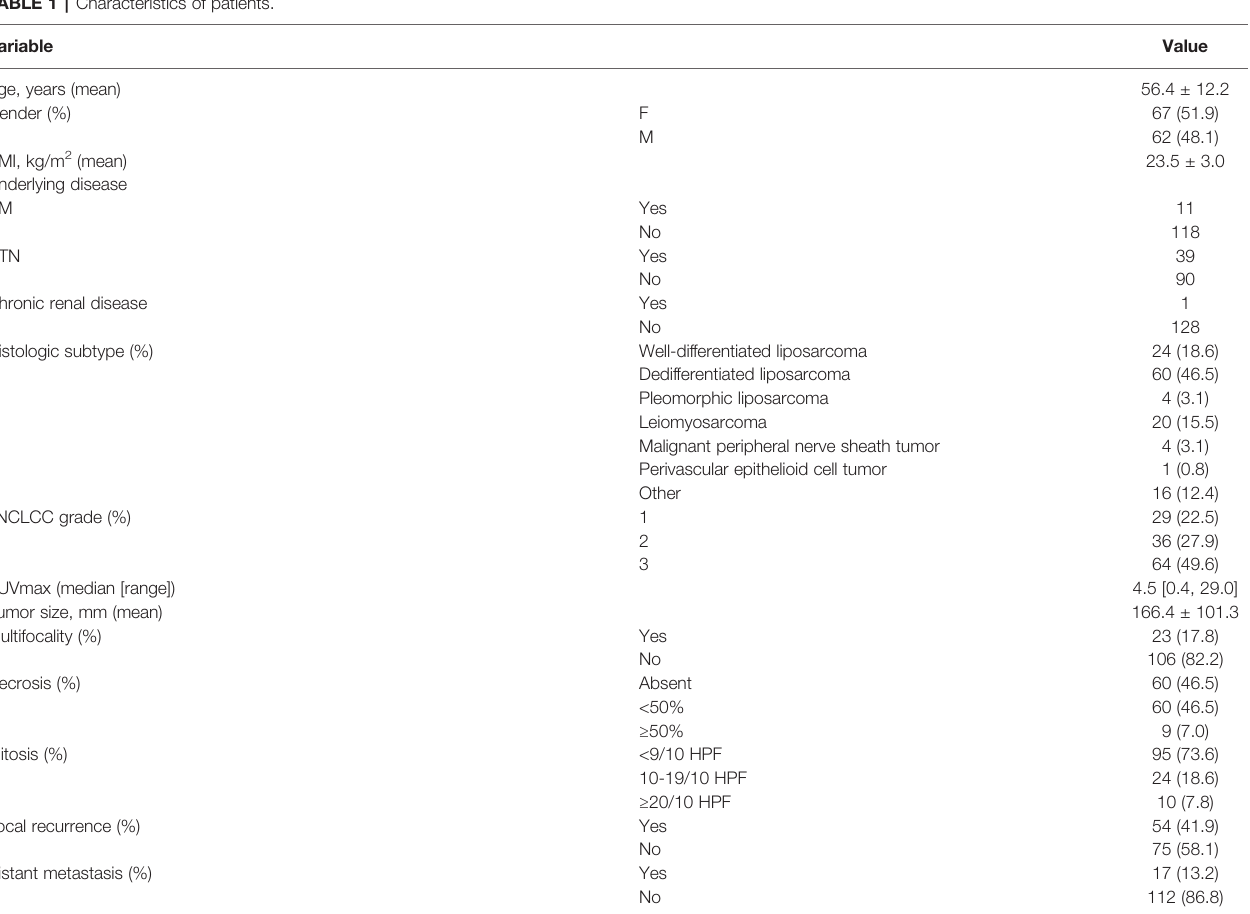
TABLE 1 | Characteristics of